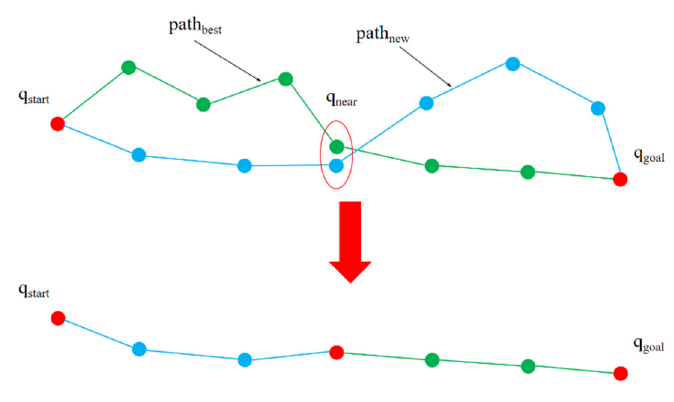
Figure 6. Schematic illustration of the algorithm flow chart of path fusion.